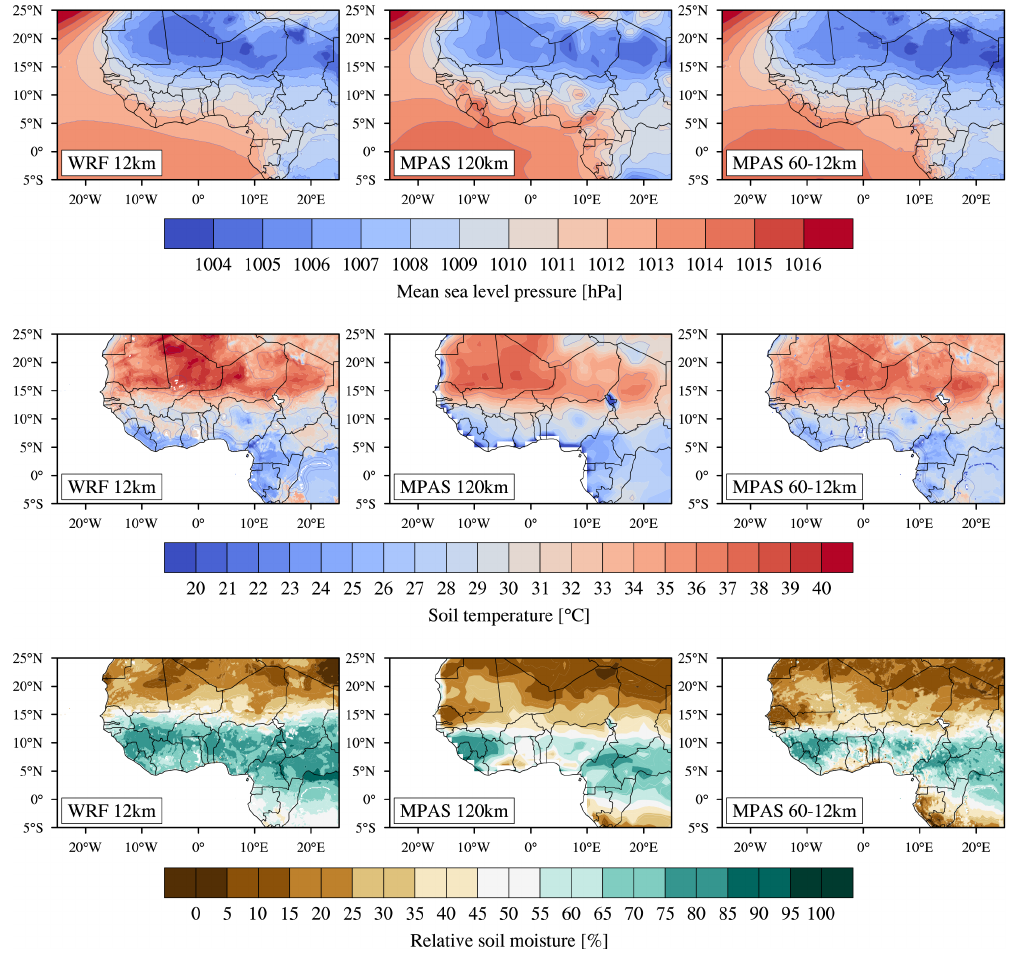
Figure 11. (Top) mean sea level pressure, (middle) mean soil temperature and (bottom) mean relative soil moisture over land for July 1982 for the WRF reference and the MPAS model runs.